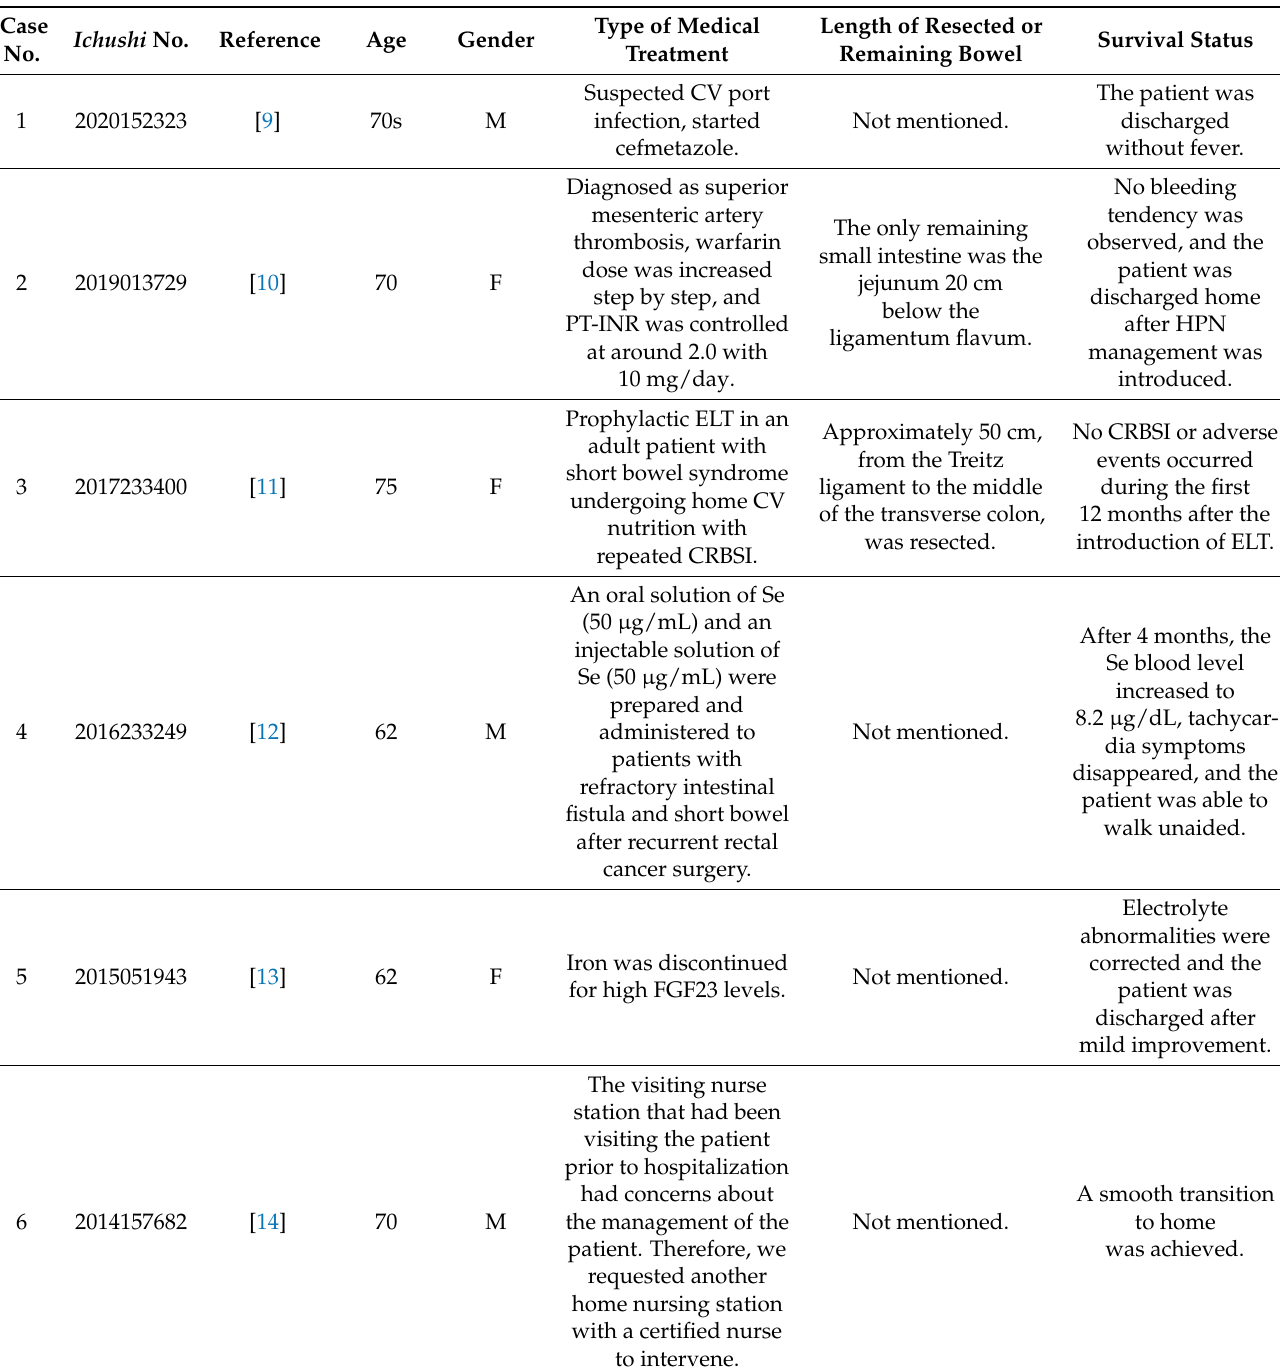
Table 2. Available literature on the recurrence of short bowel syndrome in Ichushi